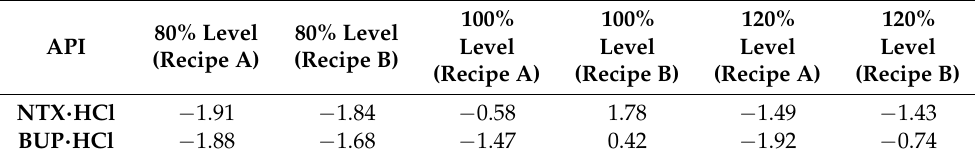
Table 5. Accuracy results (mean values) obtained for three concentration levels for both